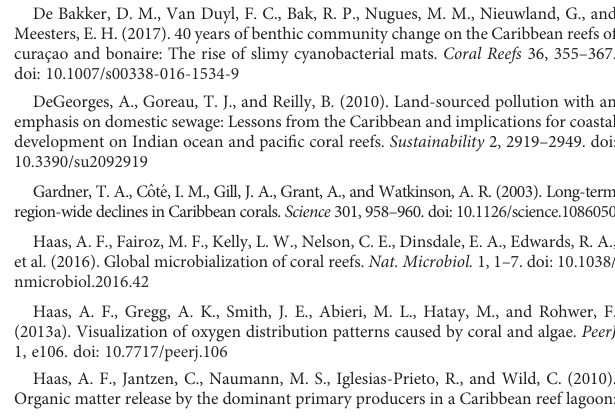
SUPPLEMENTARY FIGURE 1 Two-dimensional oxygen distribution patterns of algae under forced- fl ow conditions during day and night time. All experimental images (A – D) are from Haas, Gregg et al. (2013). Simulation images (E, F) are steady state modelling calculations. Arrows indicate direction of water movement, forced at an average speed of 5 cm s -1 . Experimental oxygen distribution patterns are shown in (A) for the day time and in (B) for the night. (C, D) show the calibrated oxygen levels following the image analysis procedure described in Haas, Gregg et al. (2013) for (A, B) , respectively. (E, F) show the steady state simulation output for day and night, respectively.